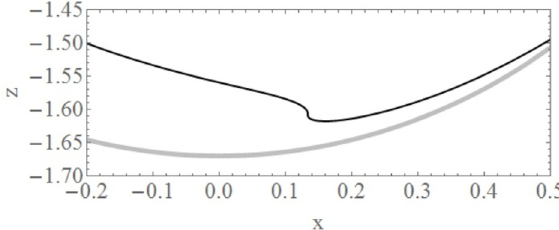
Figure 10 . Segmented string with 300 kinks after a quench ( ∆ t = 8 , (cid:15) = 0 . 095 ). The wave bounces between the two endpoints and eventually it breaks. At this point, a cusp/anticusp pair is